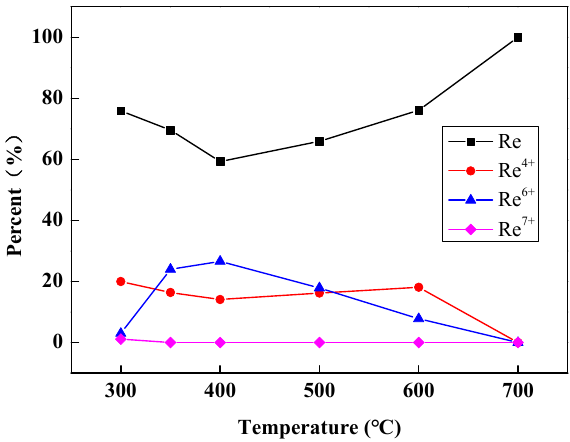
Figure 6. Oxidation state atomic content changes of ammonium perrhenate (D 50 was 71.17 µm, specific surface was 26.93 m 2 /kg) hydrogen reduction reaction at different temperatures.